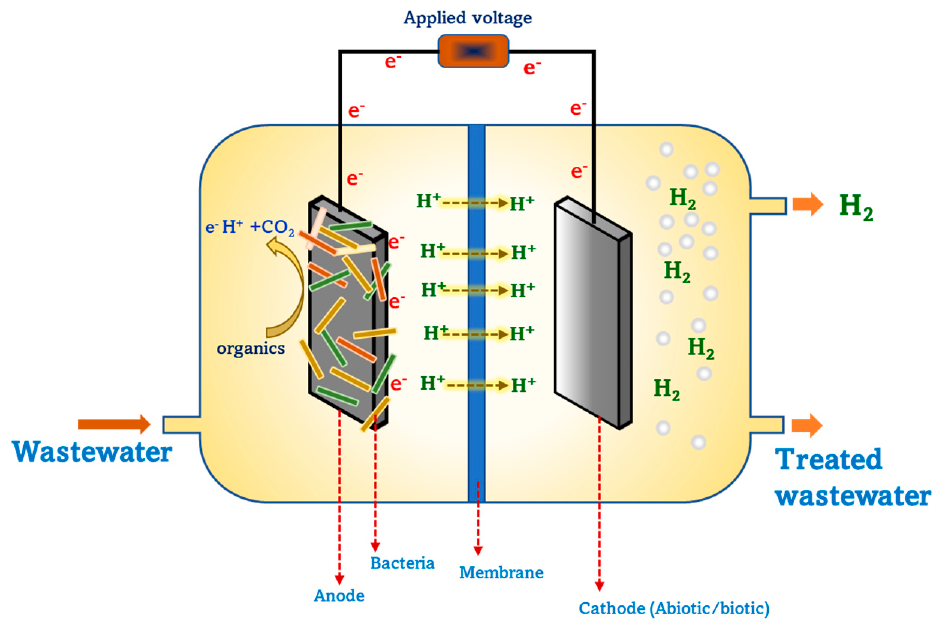
Figure 2. Schematic representation of a double chambered MEC for biohydrogen production. 170